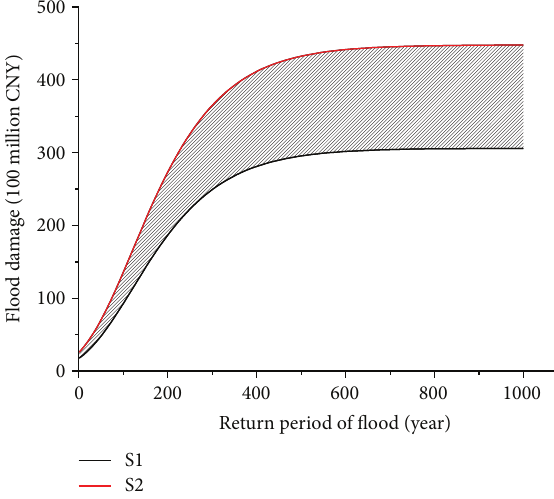
Figure 9: The impact of economic